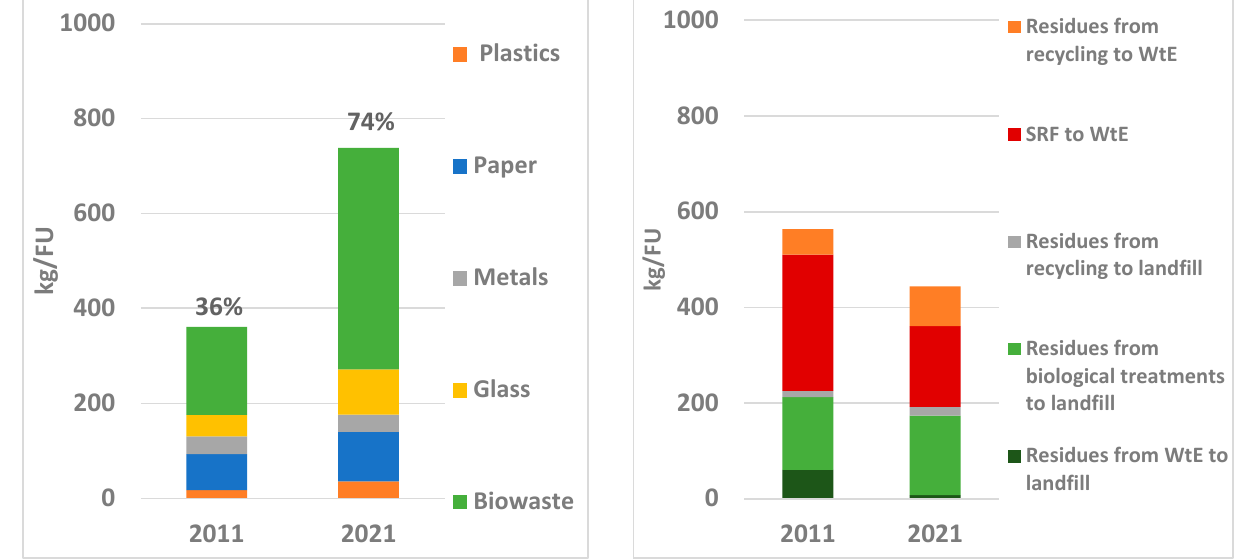
Figure 4. Comparisons between amounts of separately collected waste streams in Procida in 2011 and 2021 ( left ), and amounts sent to thermal treatments or disposal in landfill in the same years ( right ). Data source: W-MySir [7].